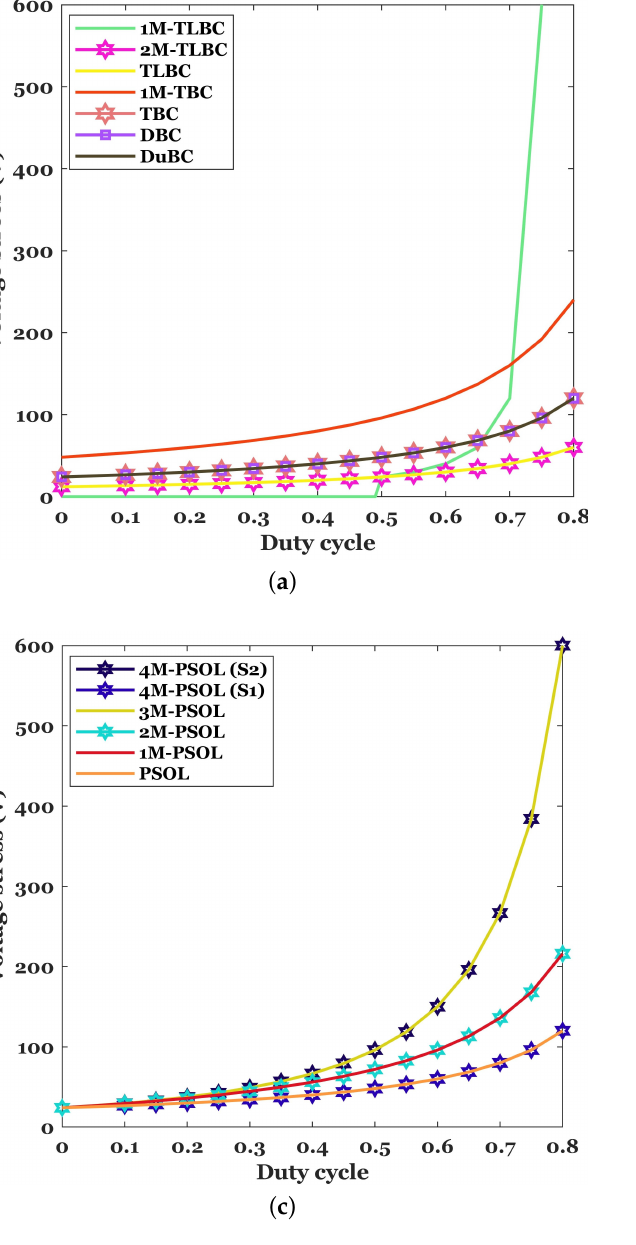
Figure 28. Voltage Stress on Switch S of Converters ( a ) Group 1 (DBC, TBC, 1st M-TBC, DuBC,